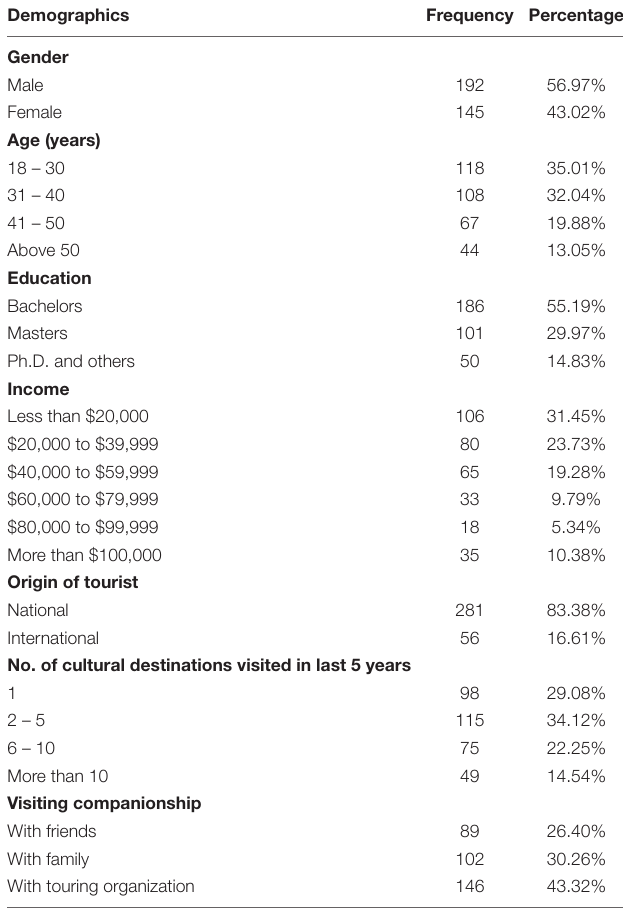
TABLE 1 | Demographic analysis of the